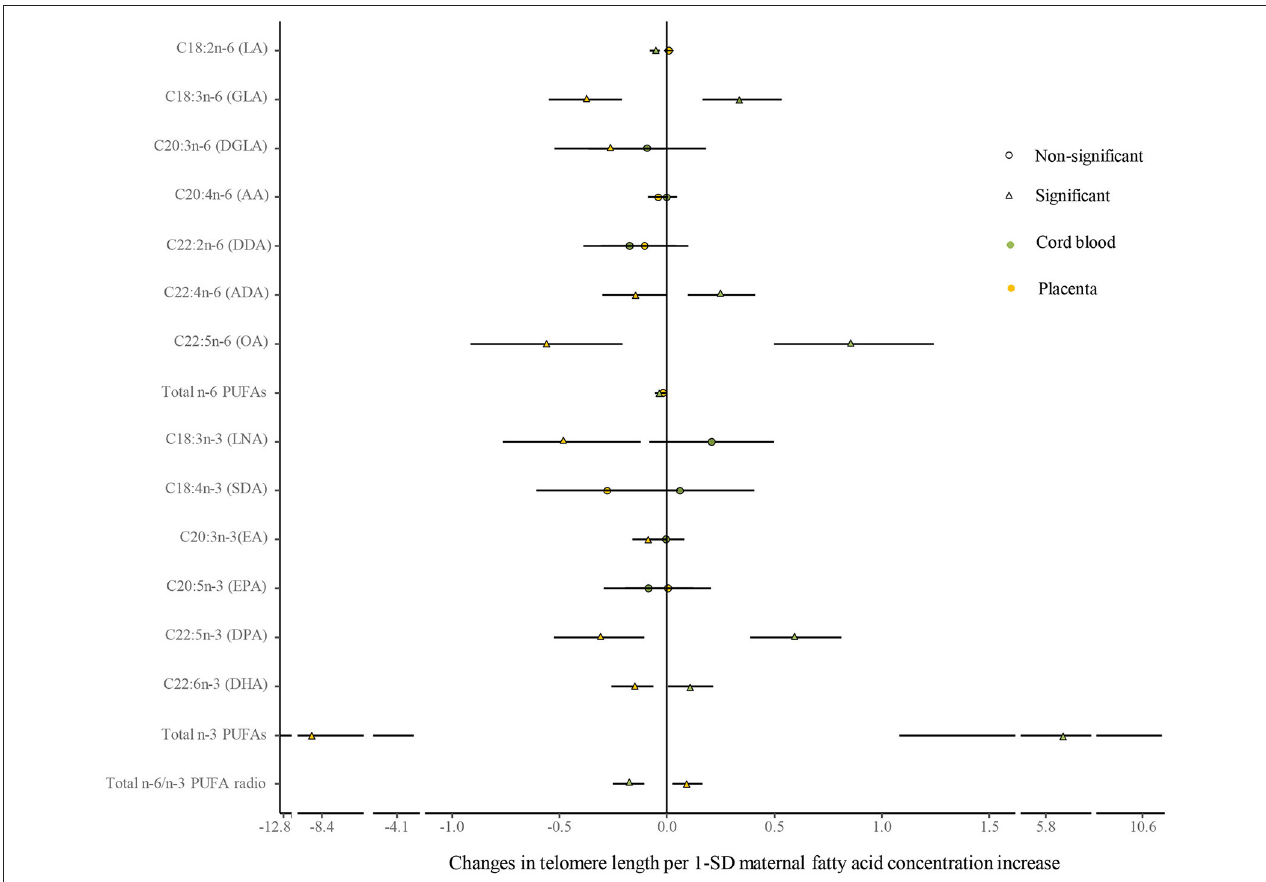
FIGURE 2 | Analysis of the differences in the associations of maternal erythrocyte fatty acids and TL between the cord blood and the placenta by continuous univariate regression. The continuous model is used to include the SD score as continuous concentrations of fatty acids, where fatty acid concentrations in maternal erythrocytes are independent variables and TL are dependent variables. β -coefficients and 95% CI represent changes in TL with 1-SD increase in fatty acid concentration. Circle: non-significant; triangle: significant; color green: the cord blood; color yellow: the